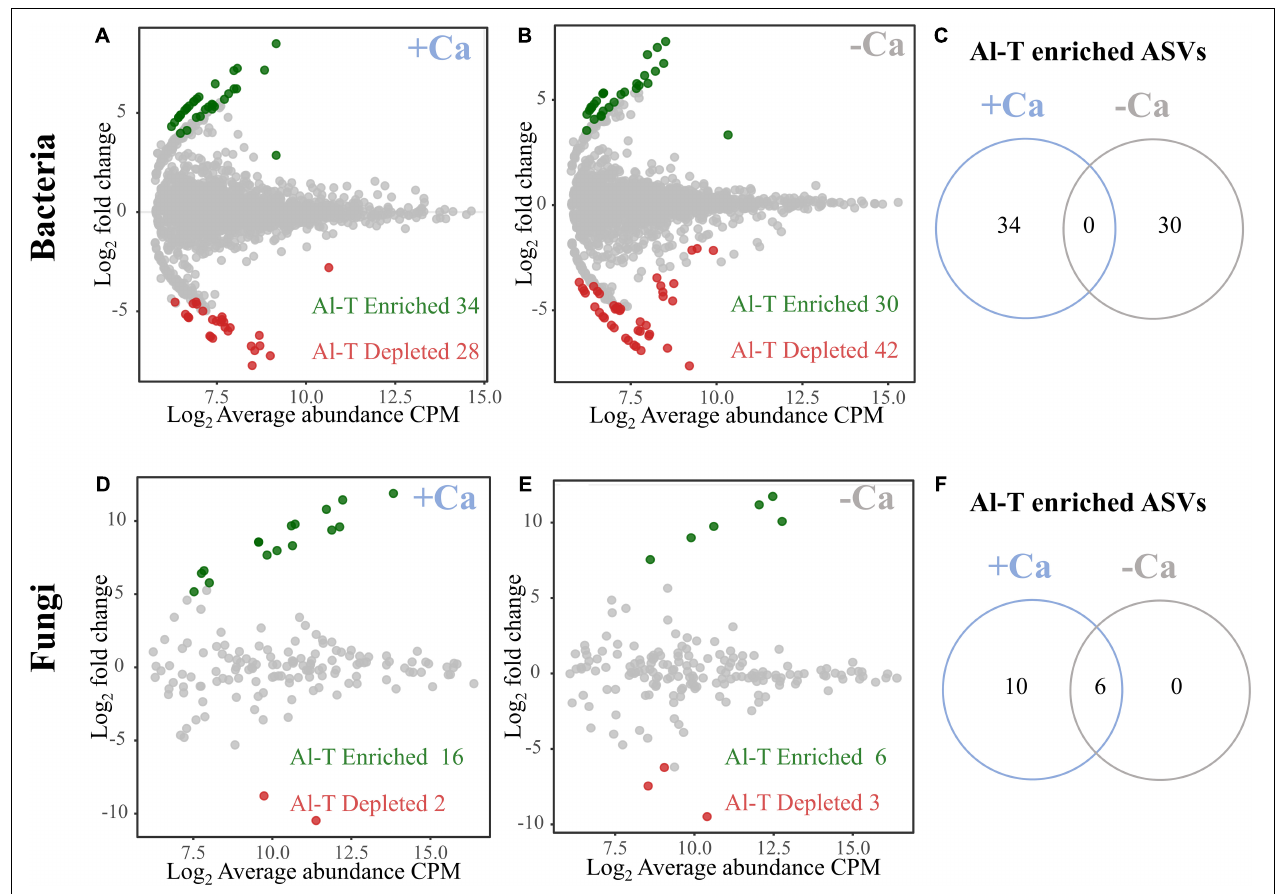
FIGURE 5 | Special sets of bacteria (A–C) and fungi (D–F) enriched and depleted in the rhizosphere of the Al-tolerant rice genotype under liming (+ Ca) and non-liming ( − Ca) conditions. The MA plots present the average abundance (in log count per million, CPM) and the log-fold change of all ASVs plotted on the x -axis and y -axis, respectively. Differentially enriched and depleted ASVs were determined on the basis of an edgeR analysis (FDR < 0.05, | log 2 fold change| ≥ 2). Green and red, respectively, indicate enriched and depleted bacterial and fungal OTUs. The number of enriched bacterial (C) and fungal (F) ASVs in the Al-tolerant rice genotype is compared between the liming (+ Ca) and non-liming ( − Ca)